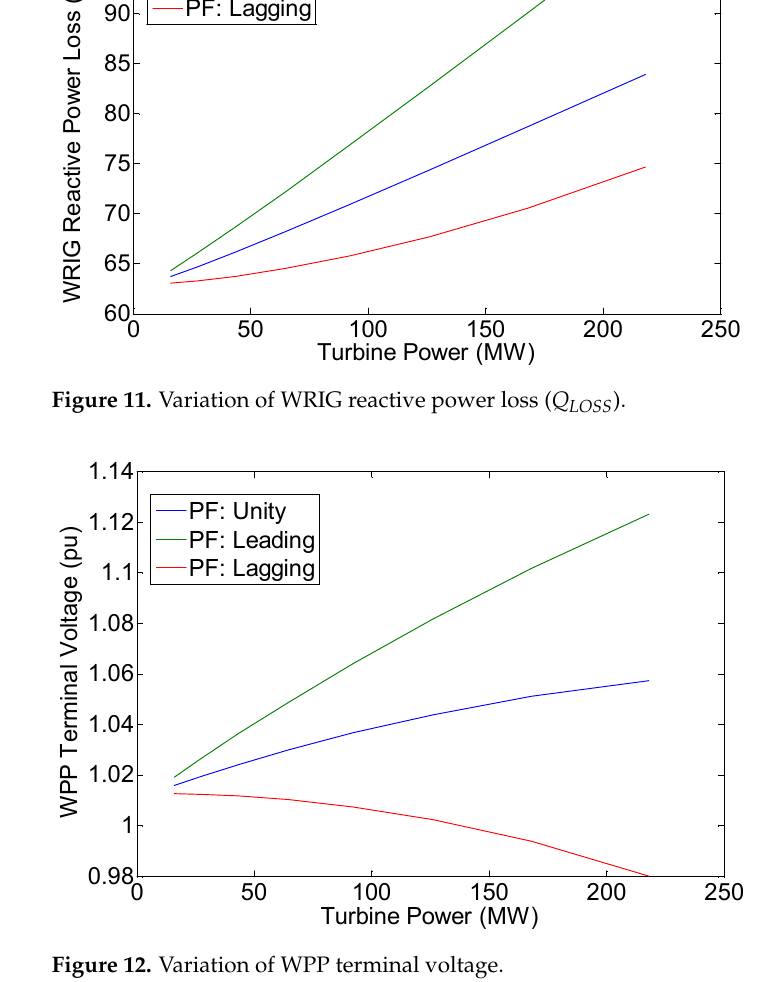
Figure 13. Variation of G1+G2+G3+G4+G5 active power output. The decrease in G1 to G5 power generation is one of the advantages of WPP instal- lation since G1 to G5 generators usually consist of conventional generators that use non- renewable energy sources. Another advantage is that the total line losses can be reduced with the increase in WPP power output (see Figure 14 and column 5 of Tables 8, 11 and 14). Tables 6–14 confirm the validity of the model proposed. This validity can also be verified by examining the results where G1 to G5 power output plus WPP power output (P g + jQ g ) is always equal to total system load plus total line loss where the line loss has been computed based on the line impedances and currents.